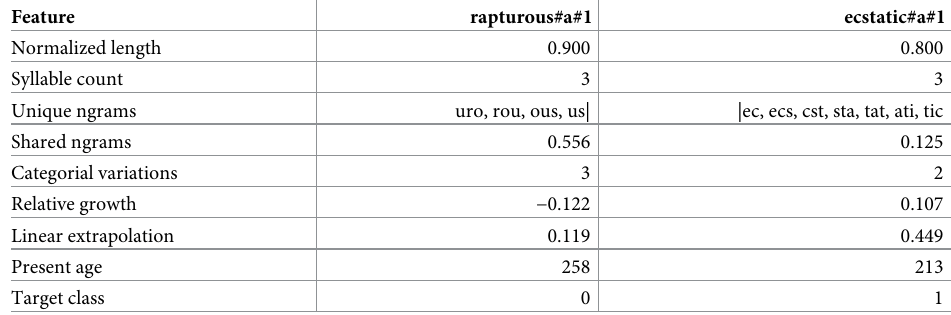
Table 4. A sample of the Test1 vector elements for two of the five words in the rapturous–ecstatic synset.